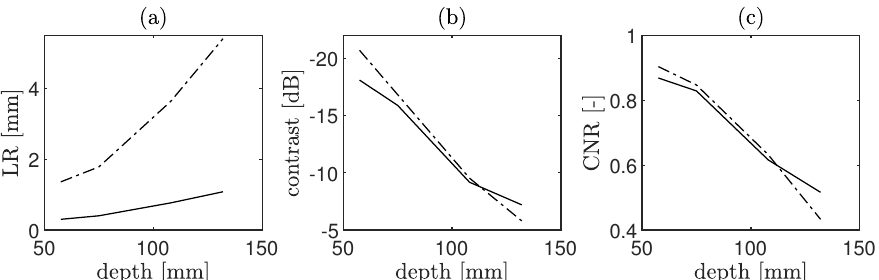
Figure 8. Computed quality metrics as a function of the imaging depth: ( a ) lateral resolution (LR); ( b ) contrast; and ( c ) contrast-to-noise-ratio (CNR). Two different methods are compared: one probe (dashed line) and CoMTUS (solid